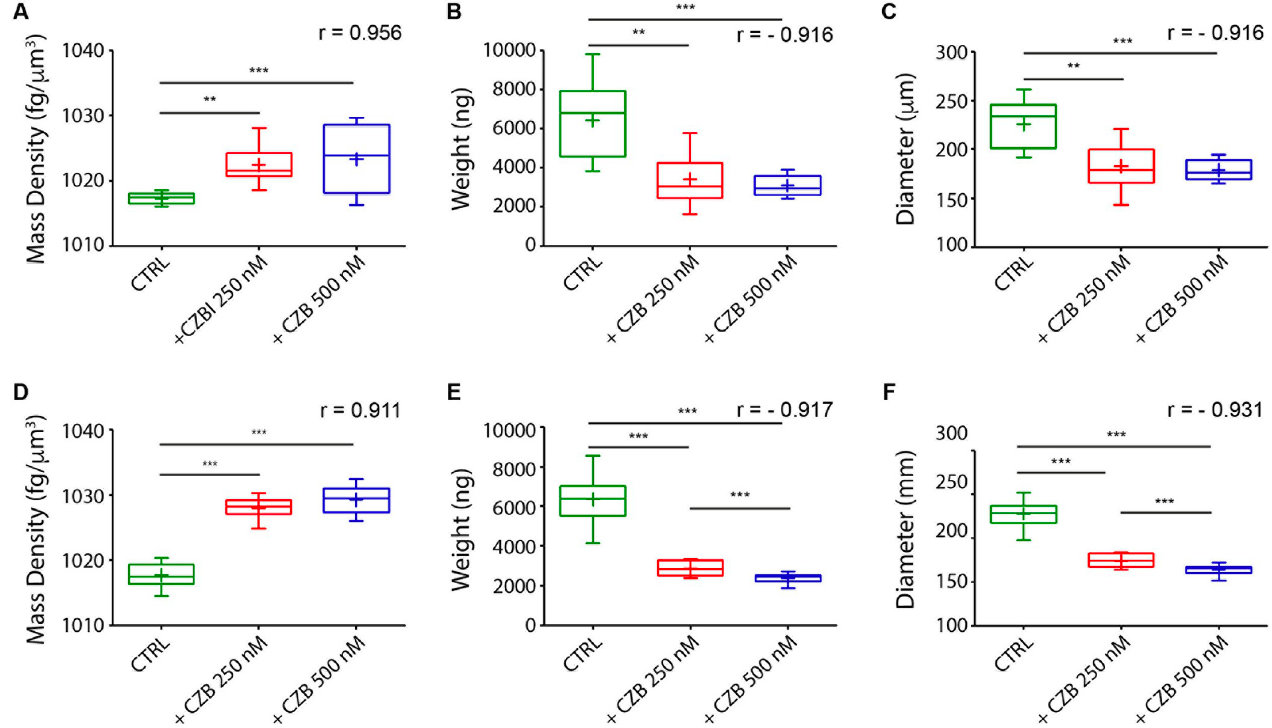
Fig 2. Measurement of mass density, weight, and diameter of LoVo spheroids treated with CZB. Measurements of mass density (A and D), weight (B and E), and diameter (C and F) of live (top panels) and fixed (bottom panels) LoVo spheroids after 10 days of treatment with CZB 250 nM (shown in red) and 500 nM (shown in blue) and relative controls (shown in green). Data are graphically depicted in box-and-whisker plots and the lines, extending from the boxes, indicate variability outside the upper and lower quartiles. �� p < 0.01 and ��� p < 0.001. The "r" Pearson correlation coefficients, able to measure the degree of relationship between the value of mass density, weight and diameter and the different drug concentrations, are indicated for each graph. The F-ratio value obtained from one-way ANOVA test estimating the total effect of fixation on W8 output data, is 0.00027, the result is not significant at p < 0.01.